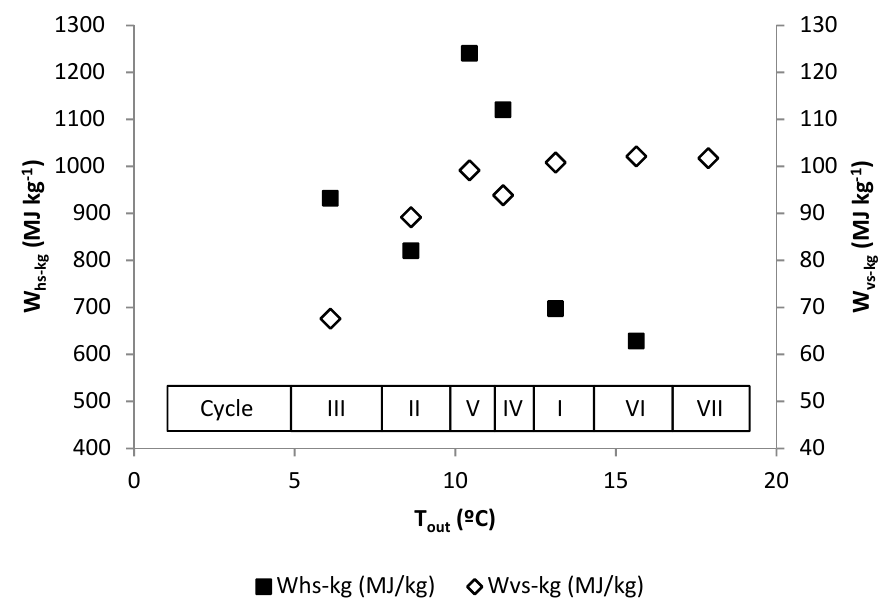
Figure 7. Energy requirements per piglet weight gain for heating (W hs-kg ) and ventilation (W vs-kg ) systems according to outdoor temperature (T out ) for each cycle.